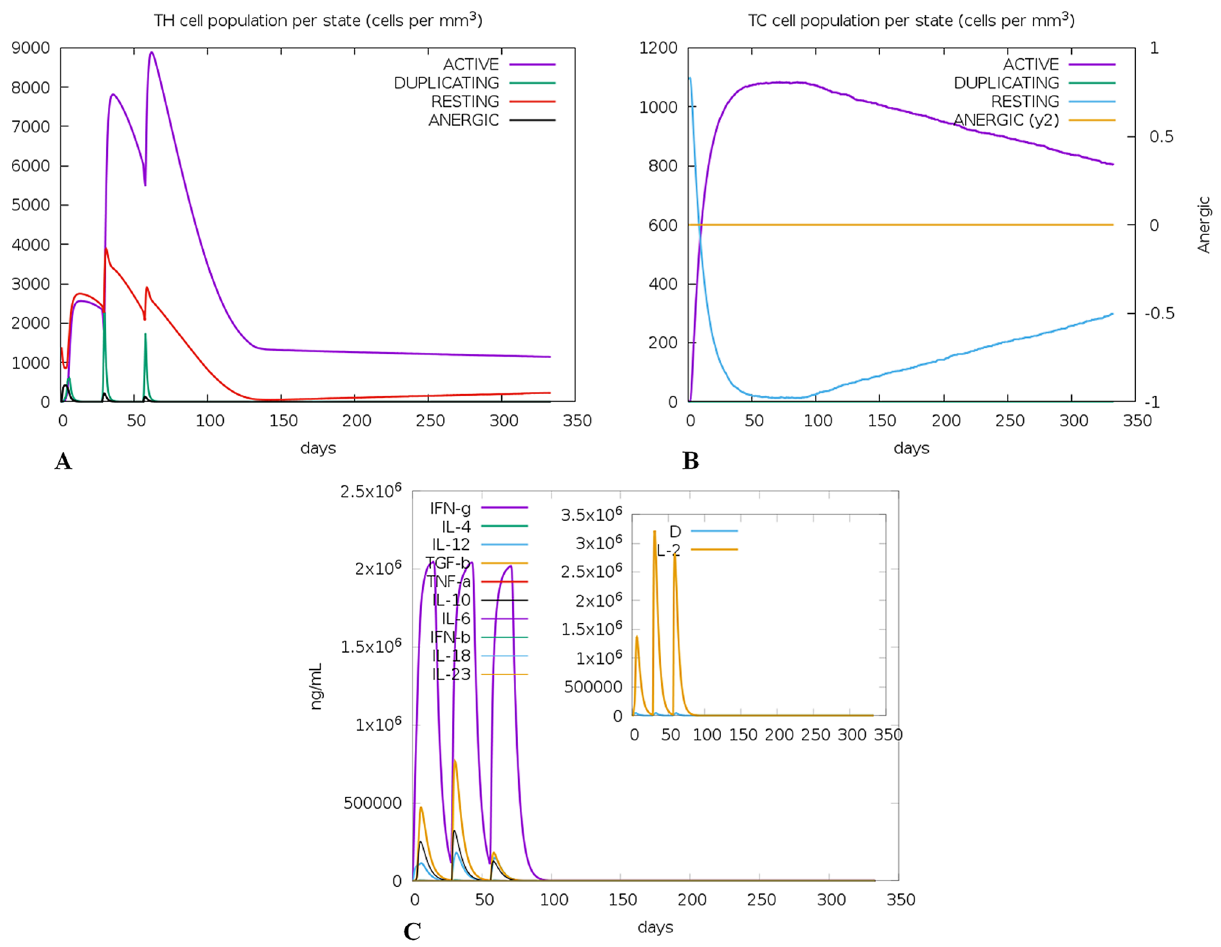
Figure 9. C-ImmSim presentation of an in silico immune simulation with the construct. ( A ) The evolution of T-helper, and ( B ) T-cytotoxic cell populations per state after the injections. The resting state represents cells not presented with the antigen while the anergic state characterizes tolerance of the T-cells to the antigen due to repeated exposures. ( C ) The main plot shows cytokine levels after the injections. The insert plot shows IL-2 level with the Simpson index, D shown by the dotted line. D is a measure of diversity. Increase in D over time indicates emergence of different epitope-specific dominant clones of T-cells. The smaller the D value, the lower the